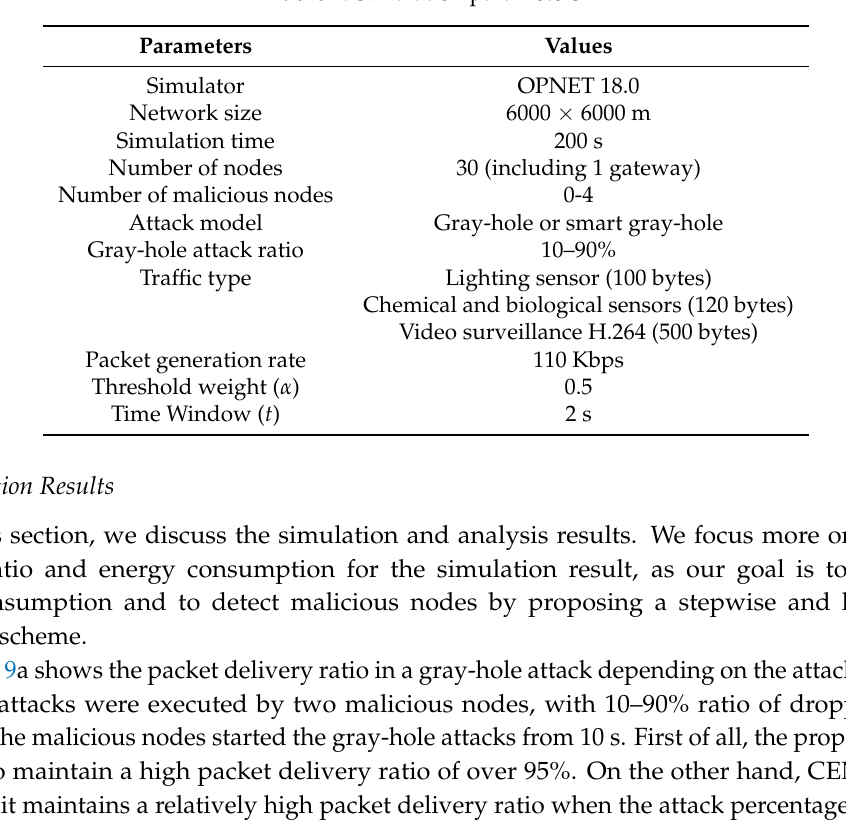
Table 1. Simulation